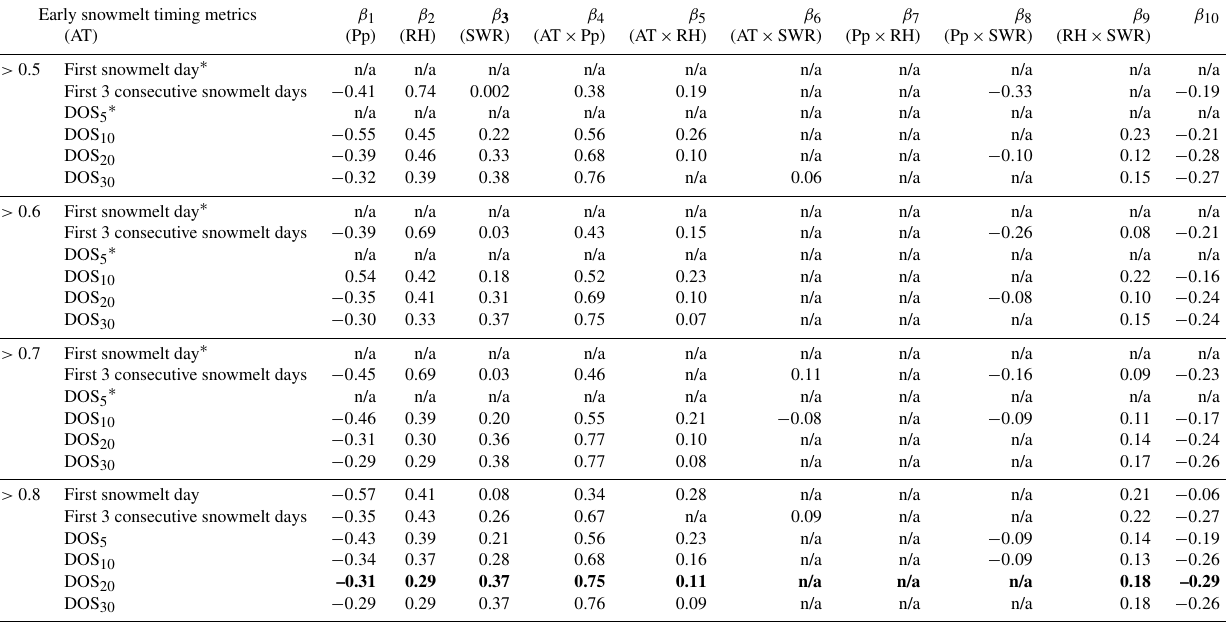
Table A4. Standardized beta coefficients for the stepwise MLR associated with the different correlation cutoffs ( r ) between hourly solar radiation and streamflow and different early snowmelt metrics. These stepwise MLR models follow the same structure as that of Eq. (1); however, in this case, predictors were standardized to estimate their relative importance. Note: AT – air temperature; Pp – precipitation; RH – relative humidity; SWR – incoming shortwave radiation. DOS xx represent the date when the xx th percentile of snowmelt days occurs. The asterisk ∗ indicates rows that do not meet all the MLR assumptions. Bolded numbers are associated with the modeling decisions used in the result and discussion